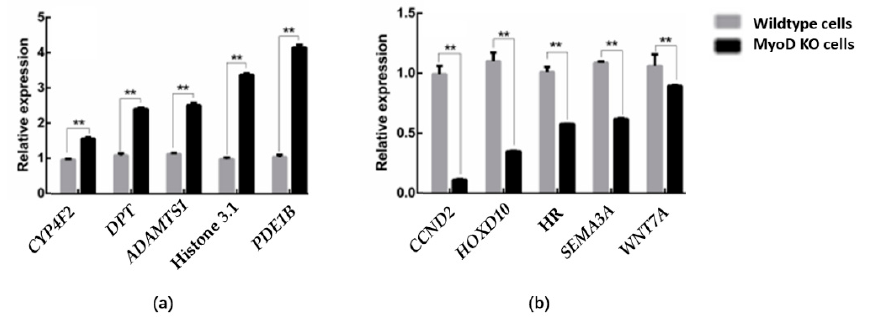
Figure 6. KEGG enrichment analysis of DEGs.